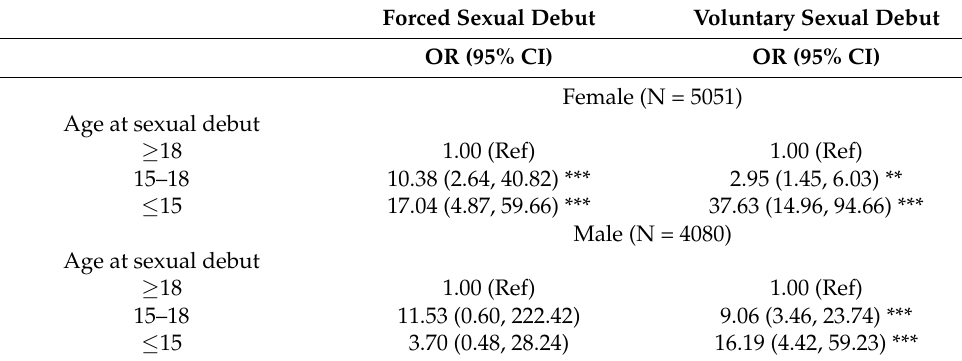
Table 3. The associations between SAs and age at sexual debut by sex and forced sexual debut experience.